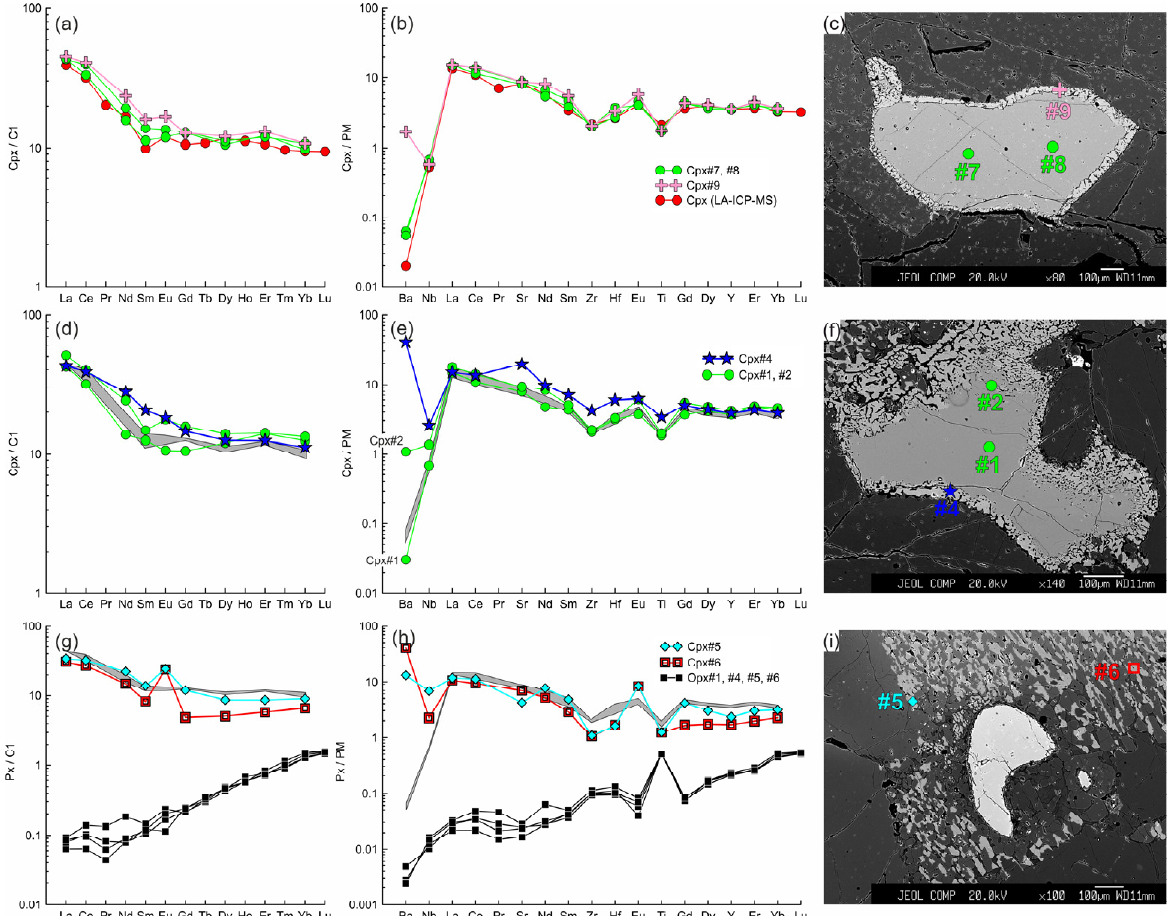
Figure 10. The trace element composition of the clino- and orthopyroxenes from sample HD24-2 normalized to the CI chondrite [31] ( a , d , g ) and primitive mantle [31] ( b , e , h ). ( a – c ) Cpx1 (#7, #8) with thin reaction zone of Cpx2 (#9) near the center of the xenolith. Trace element composition of primary clinopyroxene obtained by LA-ICP-MS is shown for comparison. ( d – f ) Cpx1 (#1, #2) with a wide reaction zone of Cpx2 (#4) near the basanite/xenolith contact. In ( d , e , g , h ), the gray field shows the compositions of Cpx1 (#7, #8). ( g – i ) Cpx3 (#5, #6) from the orthopyroxene reaction zone located near the basanite/xenolith contact. Location of the primary orthopyroxene (#1, #4–6) is beyond the sample areas shown on the photo.